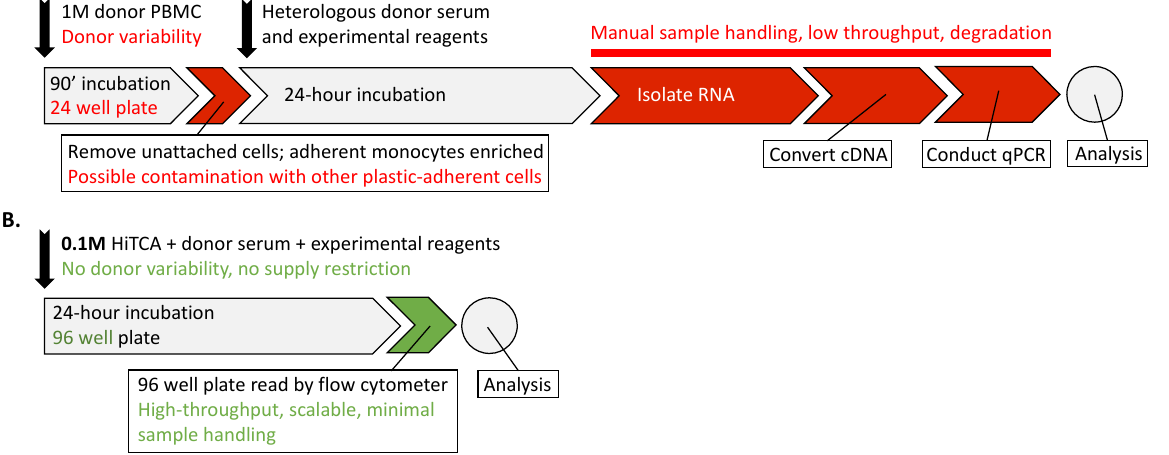
Figure 1. HiTCA enables high-throughput, scalable, and reliable bioassay of CAMP. A workflow comparison between ( A ) the ex vivo CAMP assay, which employs 1 million (1 M) PBMC, and ( B ) the High Throughput CAMP Assay (HiTCA), which employs 100,000 (0.1 M) HiTCA cells. Difficulties of the ex vivo assay are written in red text. The means by which HiTCA addresses these issues are written in green text.